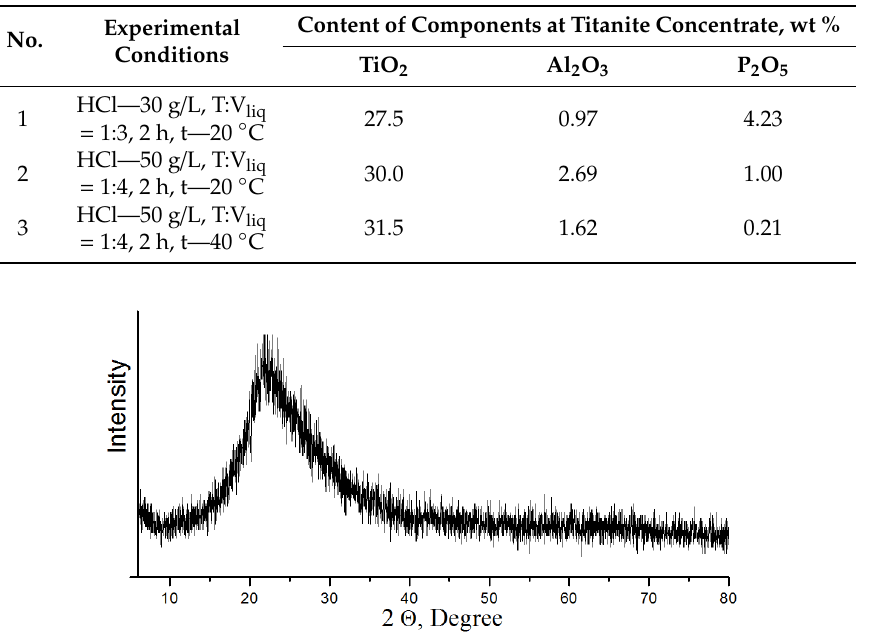
Figure 4. Powder X-ray diffraction pattern of composition (heat treatment at 500 °C).